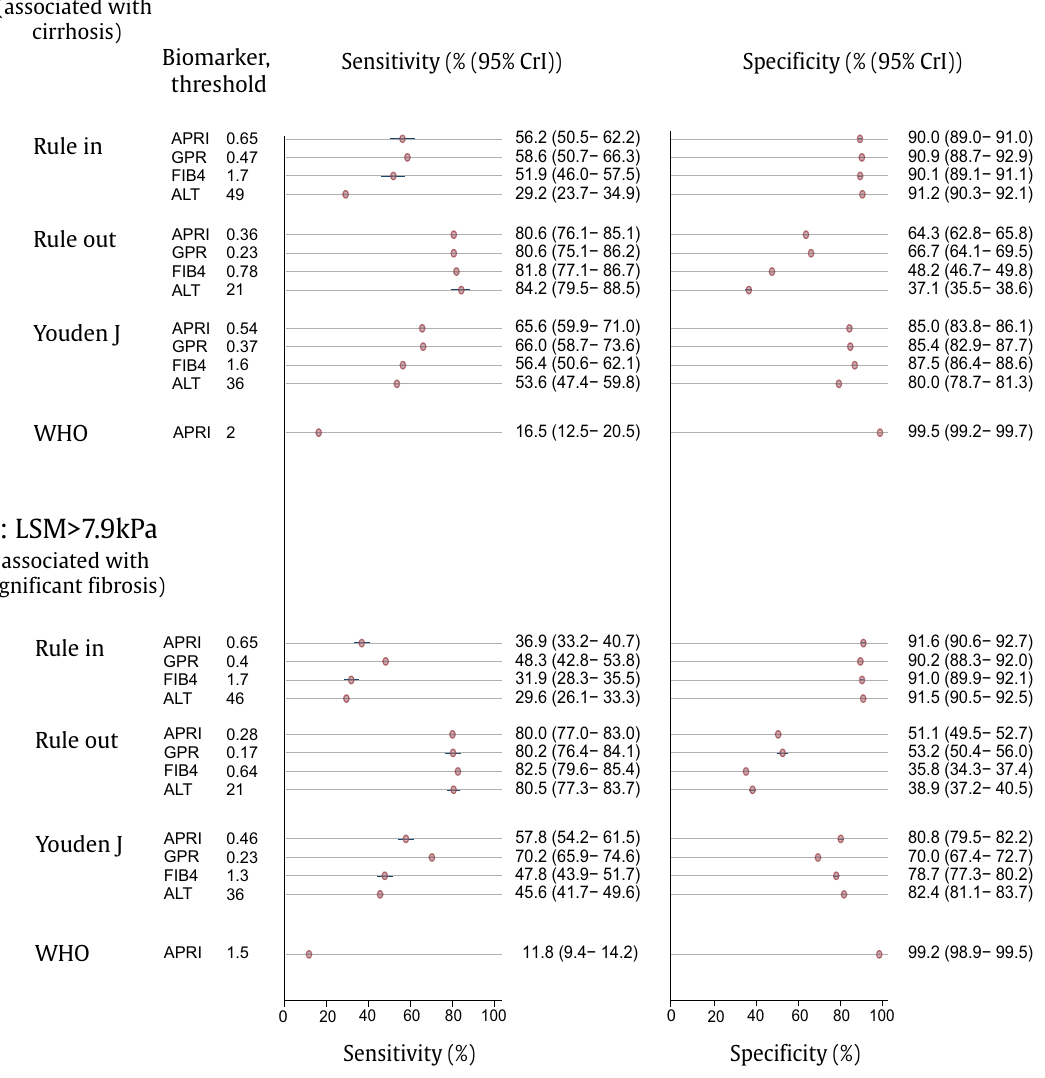
Fig. 3 | Performance of biomarkers of liver fi brosis (APRI, GPR, FIB-4) and ALT usingtransientelastographyasareferenceforthediagnosis. Thediagnosisof A LSM>12.2kPa (associated with cirrhosis) and B LSM>7.9kPa (associated with signi fi cant fi brosis): Bayesian random effects model a . Point estimates are shown as red circles with 95% credible intervals shown as error bars. CrI credible interval, APRIaspartateaminotransferase-to-plateletratioindex,FIB-4 fi brosis-4 score, GPR gamma[1]glutamyltransferase-to-plateletratio,ALTalanineaminotransferase,LSM